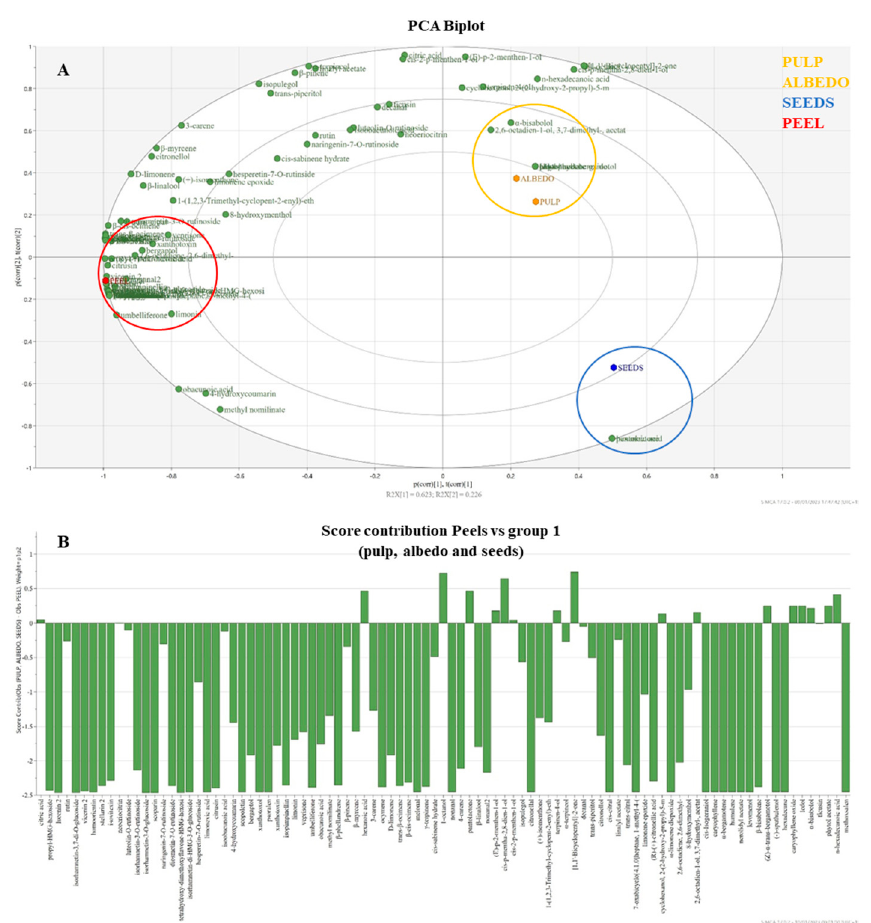
Figure 1. Biplot of PCA analysis performed on peels (red spot), pulp, albedo (yellow spot), and seeds (blue spot) for the identified VOCs and non-volatile compounds ( A ). Contribution diagram of the constituents on the distribution of samples ( B ).